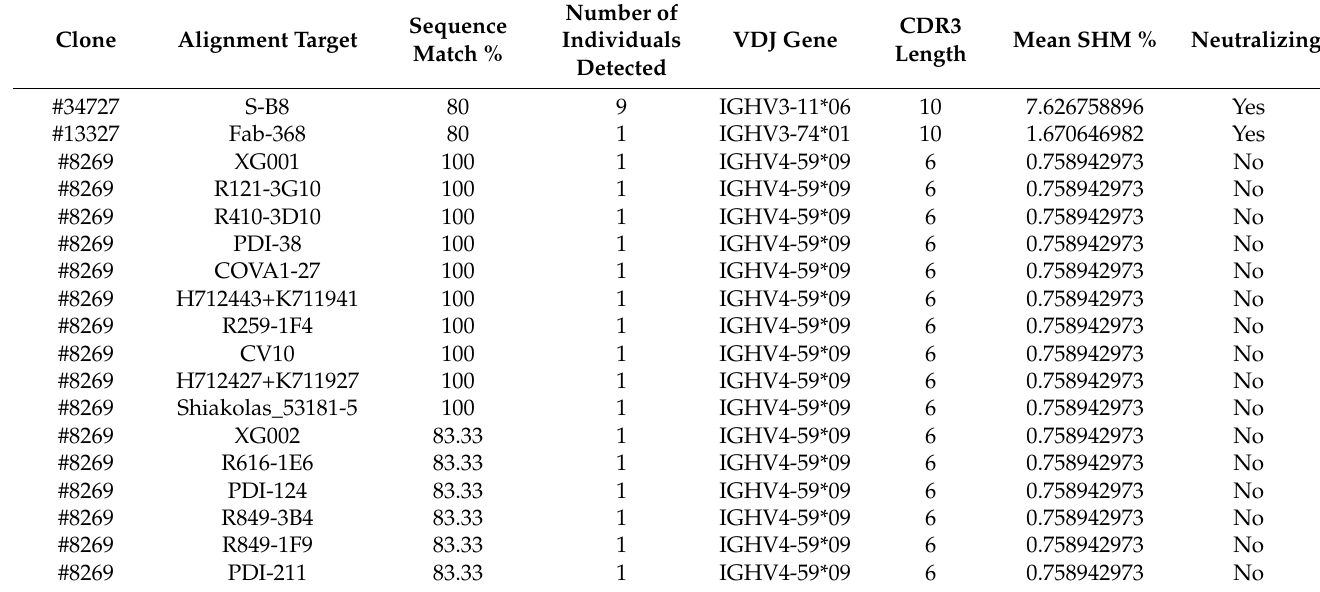
Table 1. Features of convergent clones that aligned to public